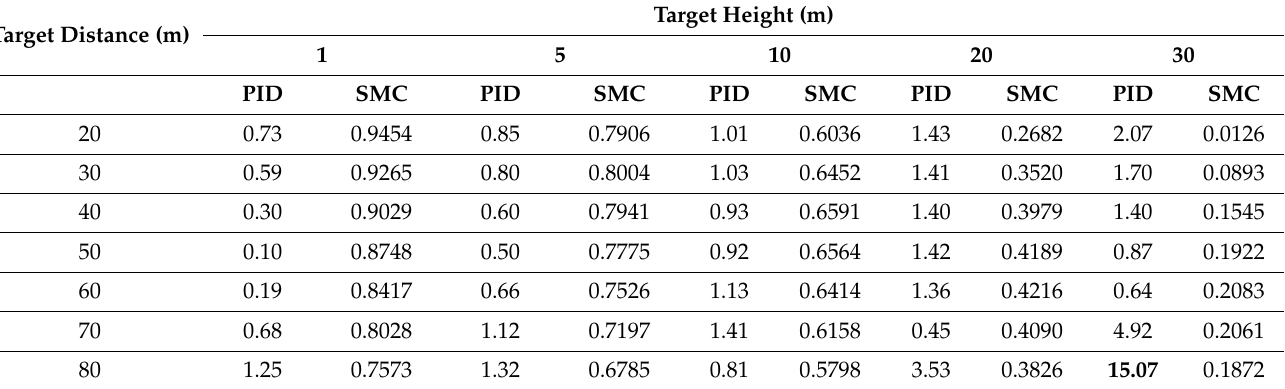
Table 6. Accuracy errors of shots fired at targets from a stationary firefighting robot with PID and